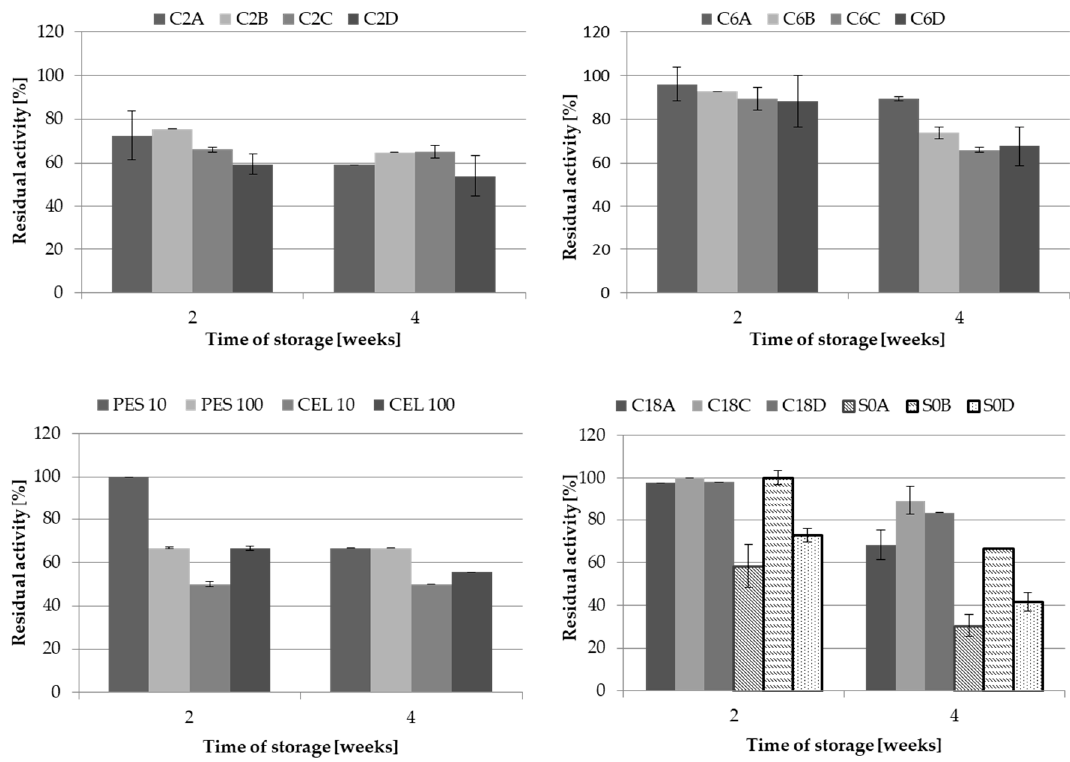
Figure 4. Stability of LAC immobilised on different carriers via covalent bond formation and adsorption during 4 weeks of storage at 4 °C.